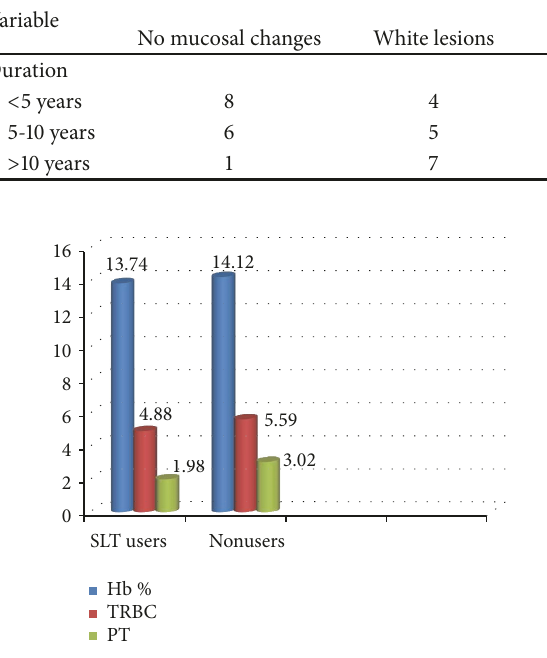
Figure 1: Comparison of Hb %, TRBC, and PT between SLT users (exposed) and nonusers.